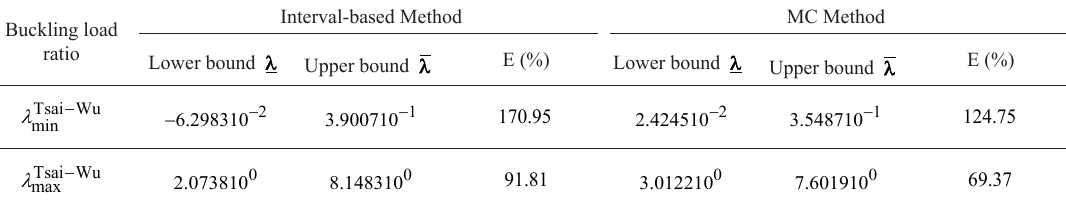
Table 3. Error-values for interval output variables obtained by the Interval-based Method and the MC method.